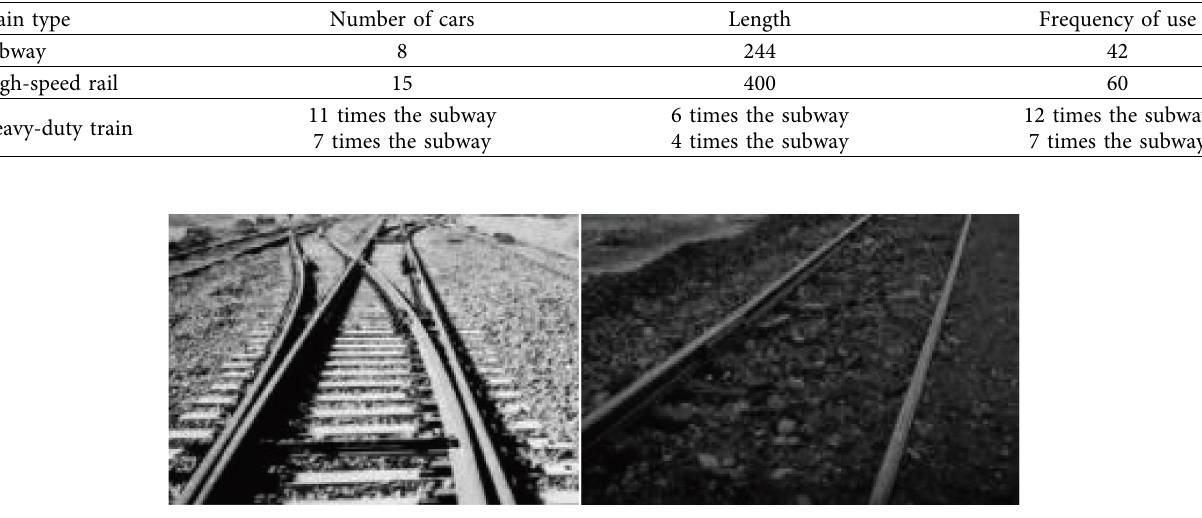
Table 2: Comparison of various train lengths and their frequency of use.